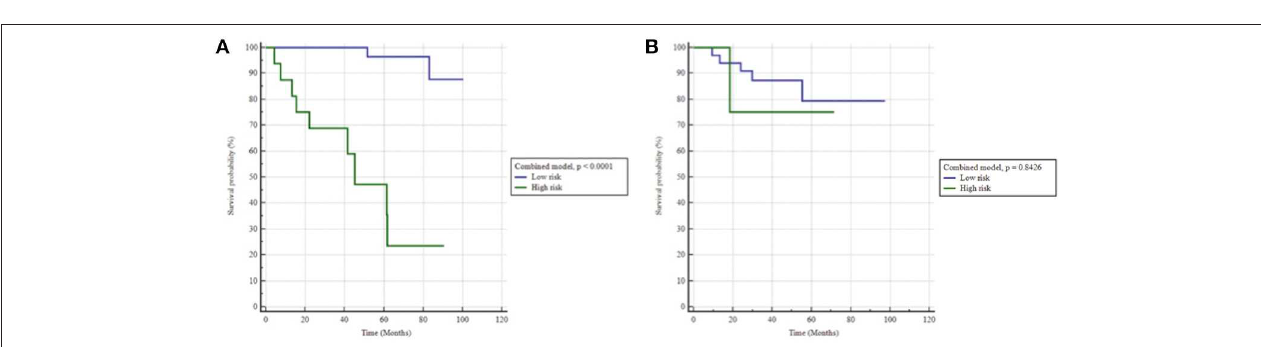
FIGURE 3 | Kaplan-Meier estimates of biochemical relapse free survival using the radiomics model in (A) training and (B) testing set.